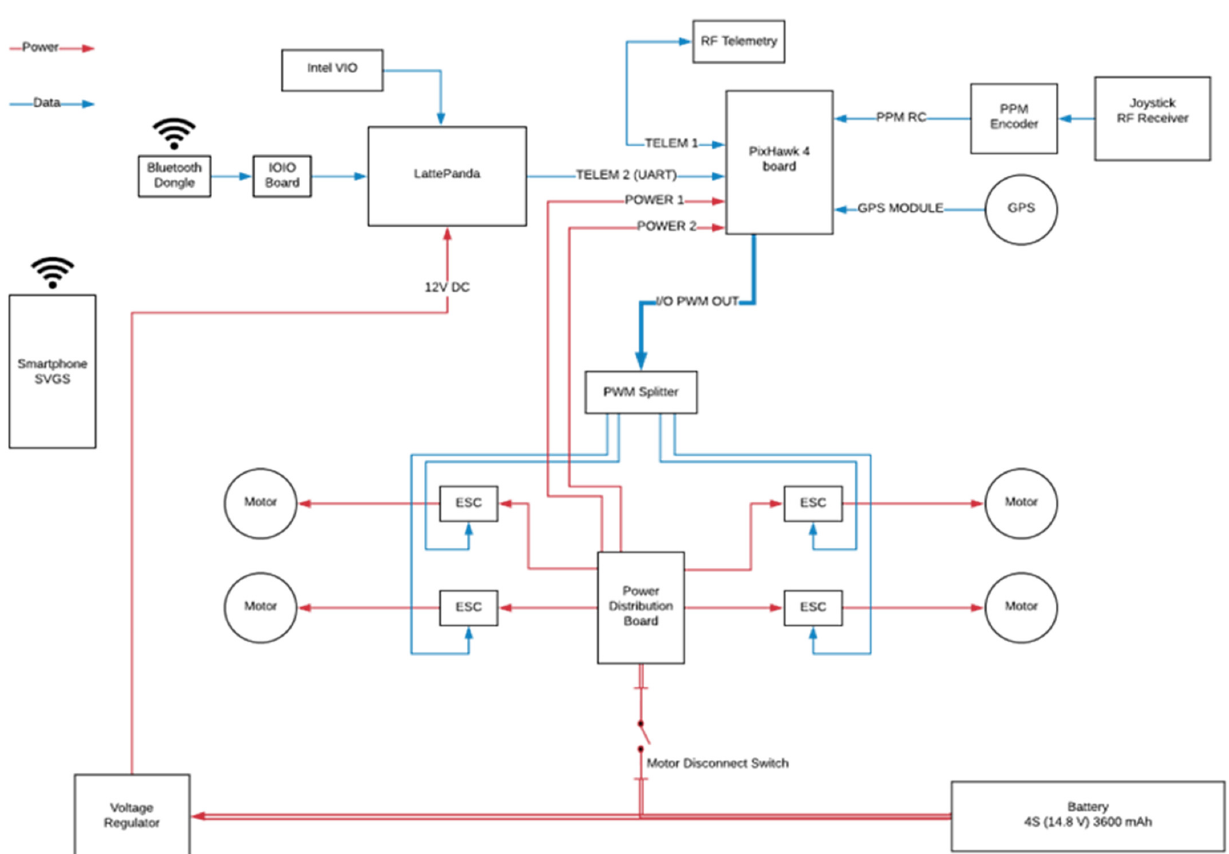
Figure 6. Interconnection diagram of the quadcopter flight platform.